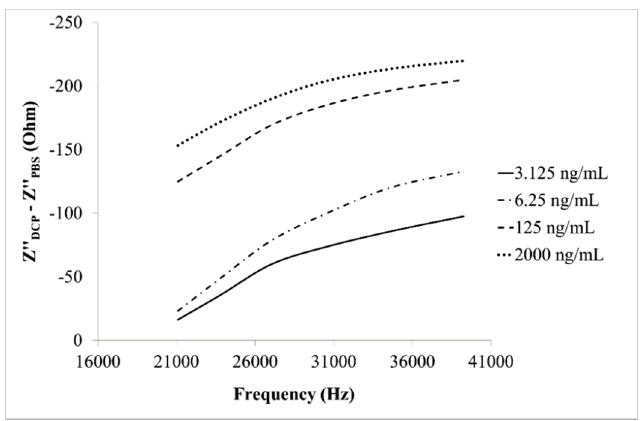
Figure 6. The imaginary part of impedance (Z") response of the immunosensor to DCP of various concentrations (3.125, 6.25, 125, 2000 ng/mL) within a specific frequency range (21.080–39.244